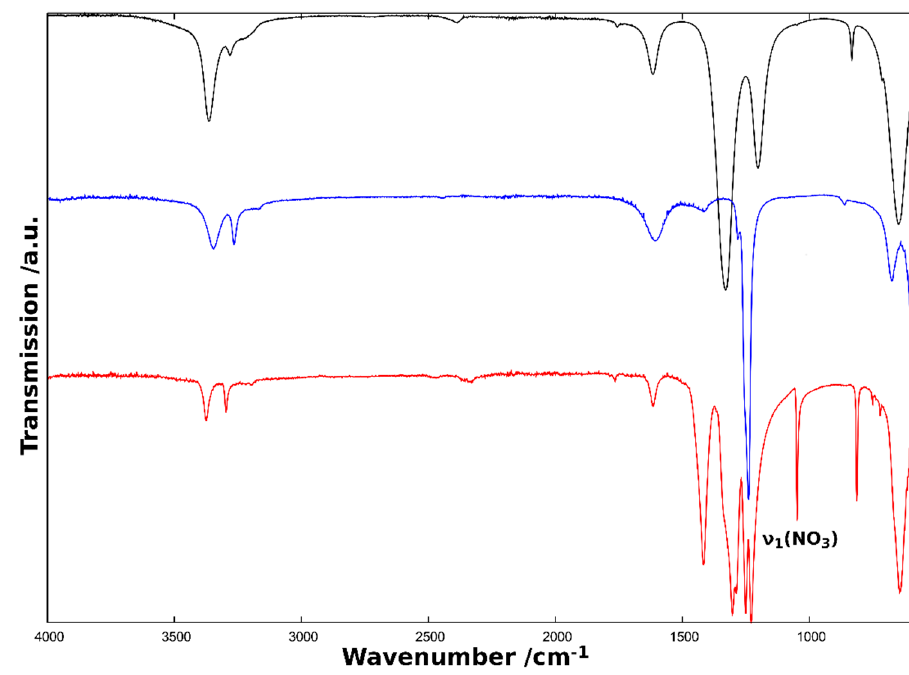
Figure 5. FTIR spectrum of Ni(NH 3 ) 2 (NO 3 ) 2 (red) in comparison with the spectra of Ni(NH 3 ) 2 Cl 2 [4] given in blue and Ni(NH 3 ) 6 (NO 3 ) 2 [5] given in black. given in blue and Ni(NH 3 ) 6 (NO 3 ) 2 [5] given in